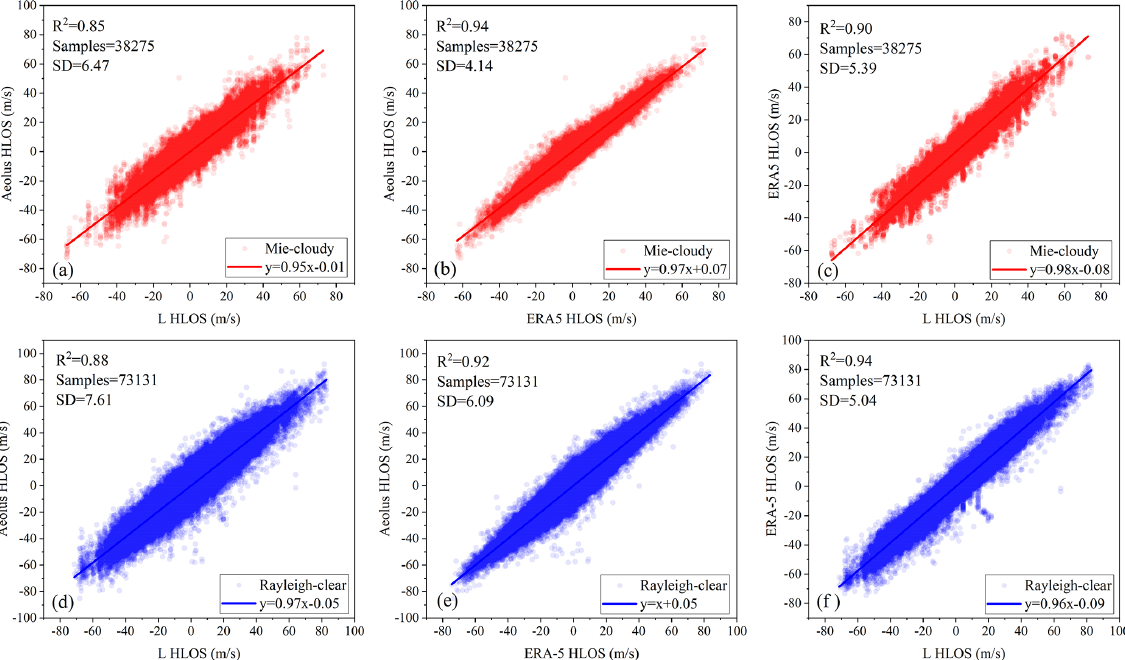
Figure 4. Comparison results of Aeolus, L-band RS, and ERA5 data in Mie-cloudy and Rayleigh-clear groups. (a, d) Aeolus vs. L-band RS, (b, e) Aeolus vs. ERA5, and (c, f) ERA5 vs. L band RS. Table 2. Comparison between Aeolus, L HLOS, and ERA5 HLOS wind. Aeolus vs. L Aeolus vs. ERA5 ERA5 vs. L Mie-cloudy Rayleigh-clear Mie-cloudy Rayleigh-clear Mie-cloudy Rayleigh-clear R 0.92 0.94 0.97 0.96